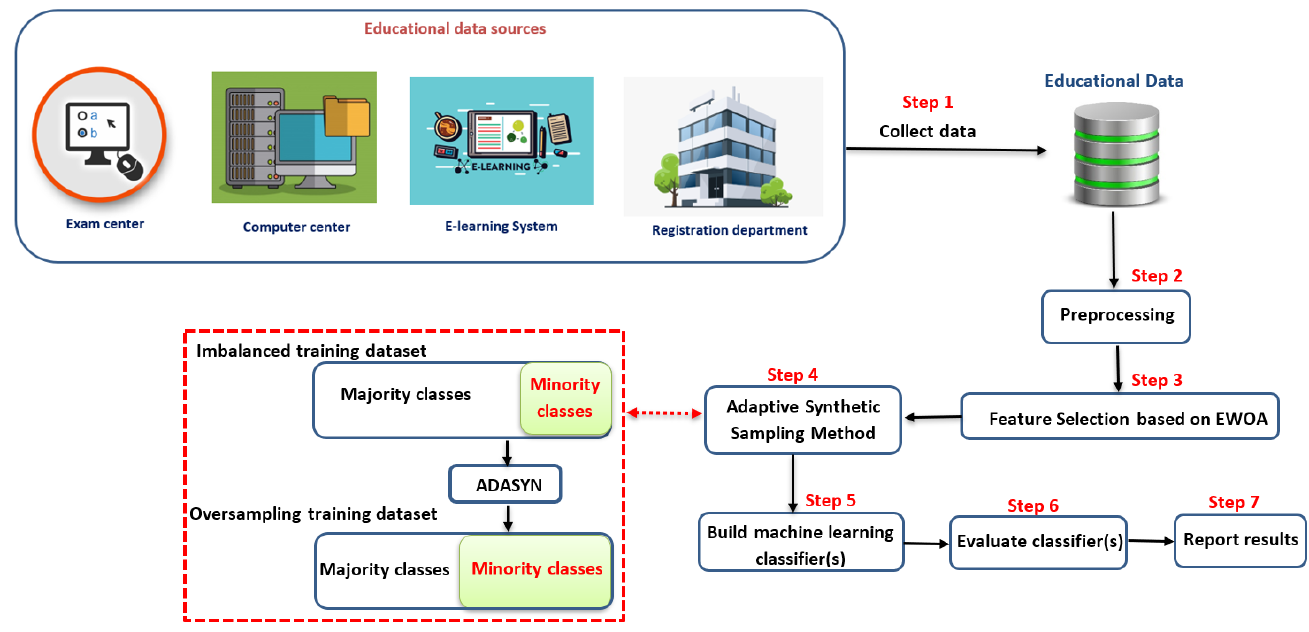
Figure 2. Proposed